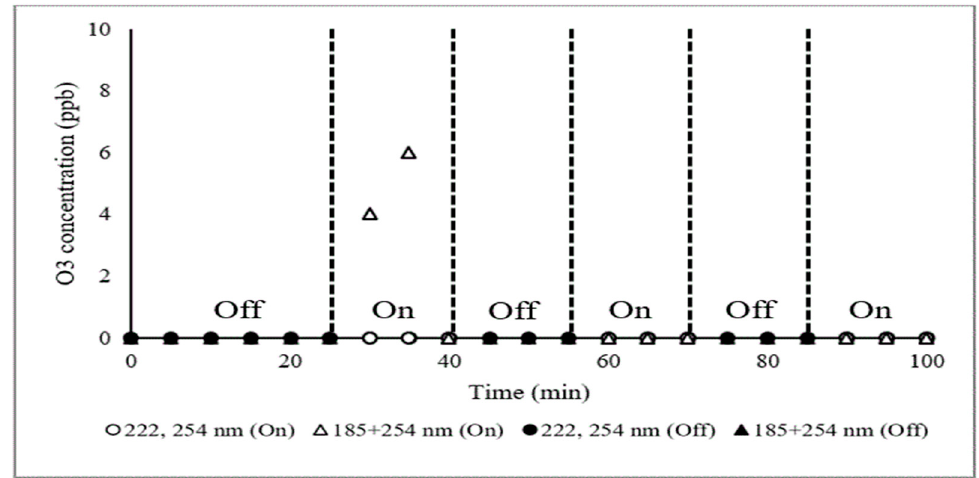
Figure 2. Mitigation of O 3 concentration with different UV wavelengths irradiating gaseous emissions inside #2 chamber. Air flow = 0.28 m 3 · s − 1 , inlet air temperature (influent of chamber #2) = 28 ◦ C, inlet air RH = 67%, outlet air temp. (inffluent of chamber #3) = 31 ◦ C, outlet air RH = 61%.